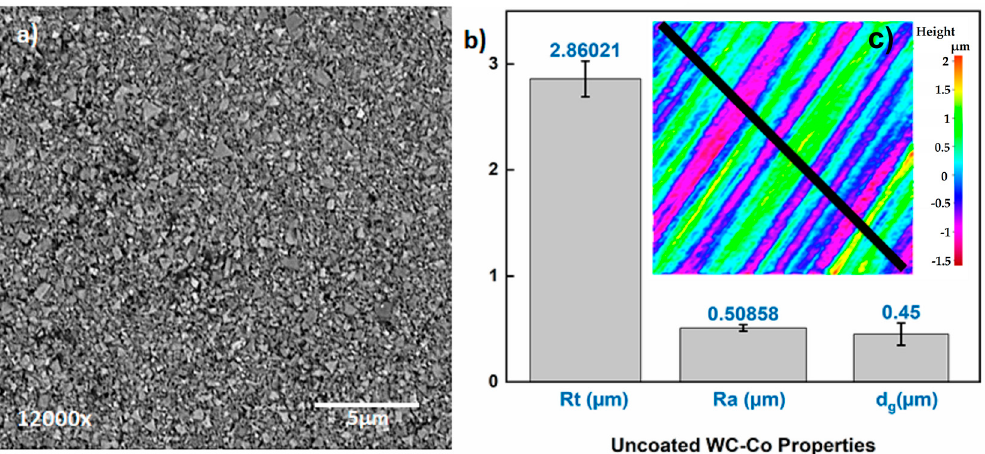
Figure 3. ( a ) Microstructure with back-scattered electron (BSE) at 12,000× magnification; ( b ) surface profile ( Rt and Ra ) at a roughness sampling length of 250 µm and average WC grain diameter d g of the tool substrate; ( c ) surface profile of the substrate.